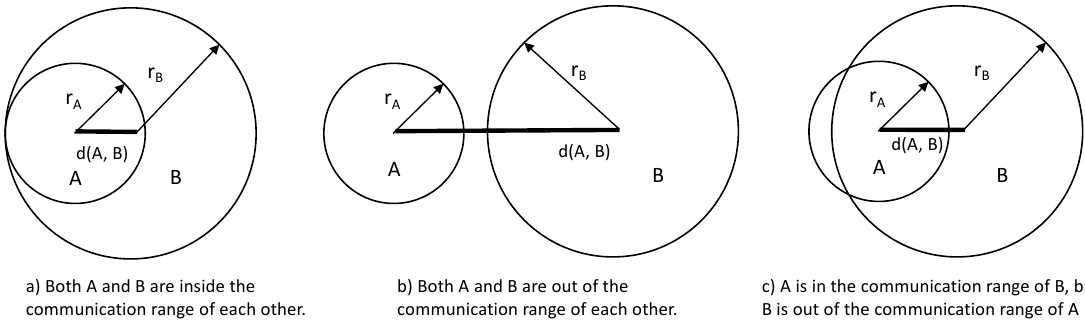
Figure 1. Communication range scenarios of two sensors nodes A and B . ( a ) Both A and B are inside the communication range of each other. ( b ) Both A and B are out of the communication range of each other. ( c ) A is in the communication range of B , but B is out of the communication range of A